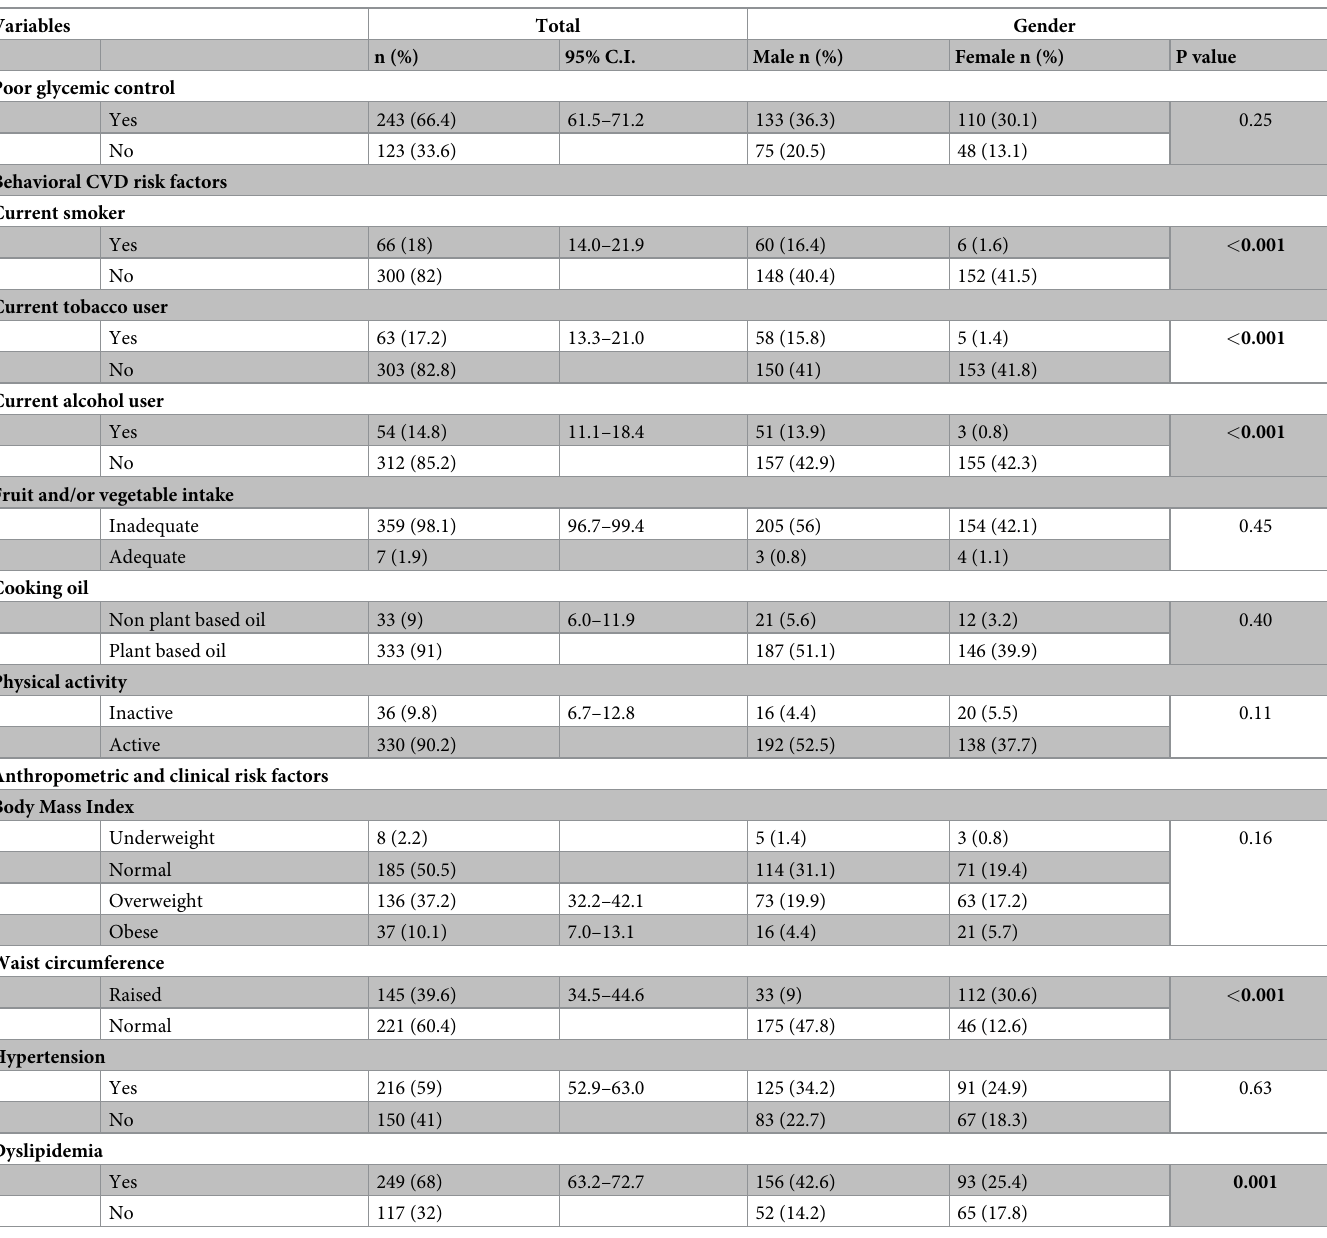
Table 3. Prevalence of poor glycemic control and other cardiovascular disease risk factors among study participants stratified by gender (N = 366).